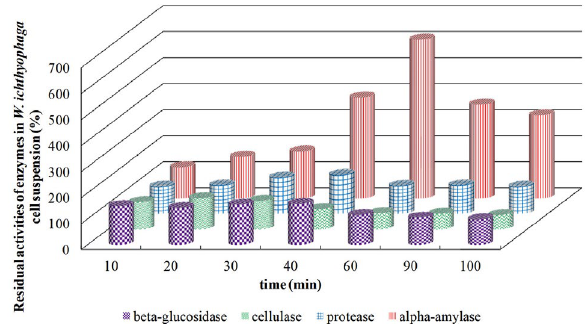
Figure 6: Residual activity of various enzymes in the W. ichthyopha- ga cell suspension in relation to homogenization time at 35 °C and a homogenization speed of 25,000 rpm. Experiments were repeated three times. Standard deviation for all measurements was less than ±